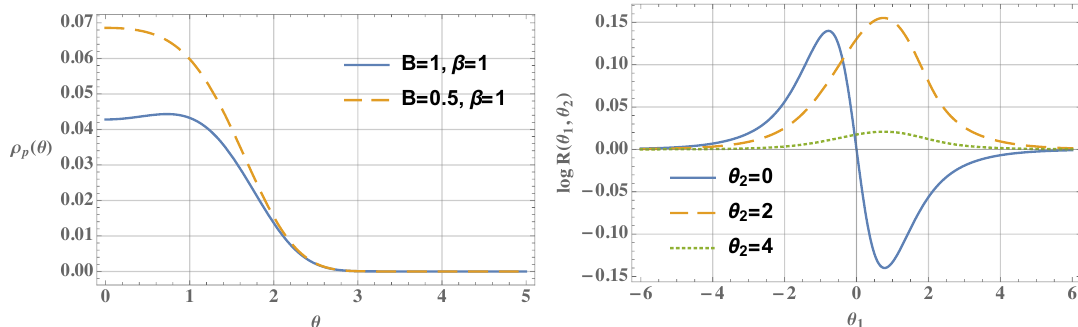
Figure 7. Left panel: plots of the density (cid:26) p ( (cid:18) ) at di(cid:11)erent values of the interaction parameter and temperatures. Right panel: we plot the phase of the pure phase factor R # ( (cid:18) 1 ; (cid:18) 2 ) for B = 0 : 5 and (cid:12) = 1.